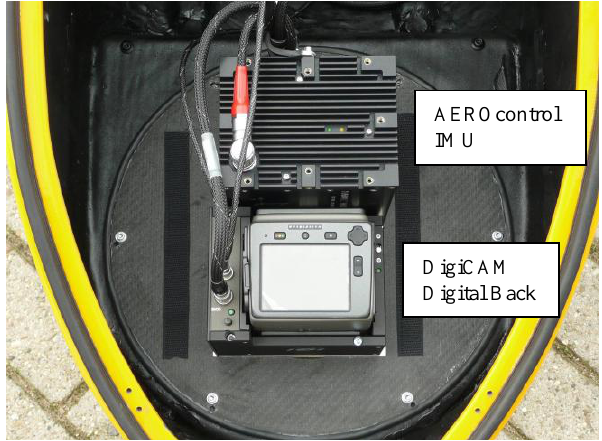
Figure 3. Sensor Installation in Geocopter GC-201 Payload Bay